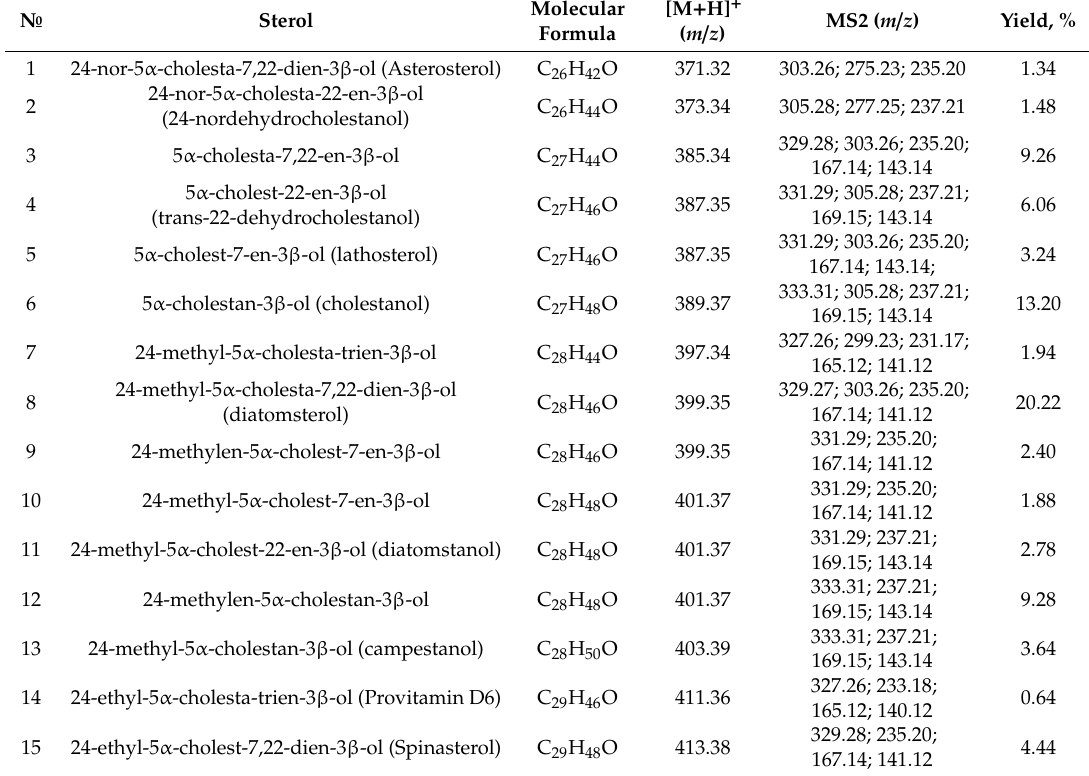
Table 1. Sterol components identified from the supercritical extract of C. frondosa japonica Semper, 1868.